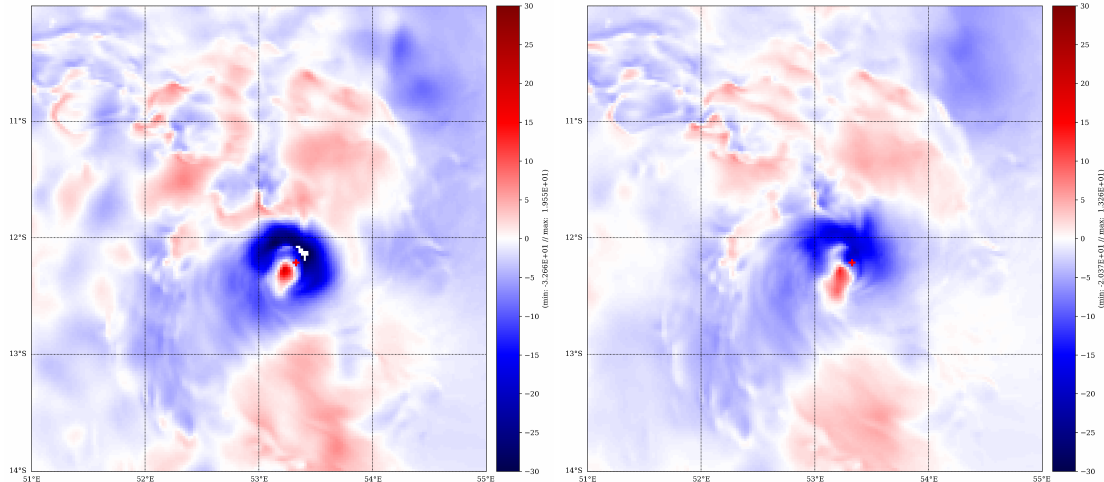
Figure 19. Analysis increments for surface wind speed with thinning of 5 km ( left ), 20 km ( right ) for SAR data assimilation. Units are m · s − 1 . Red cross is the estimated TC center position interpolated from TC position extracted from BT on 7 February 2019 00:00Z and